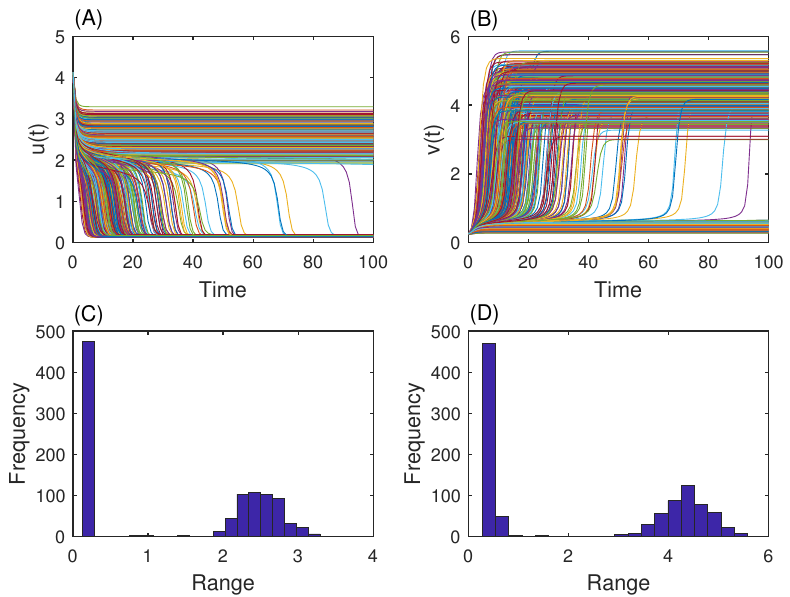
Figure 4. The 1000 generated simulations of Model (6). ( A ) Simulations of gene λ CI . ( B ) Simulations of gene LacR. ( C ) Distribution of the steady state of λ CI at t = 50. ( D ) Distribution of the steady state of LacR at t =